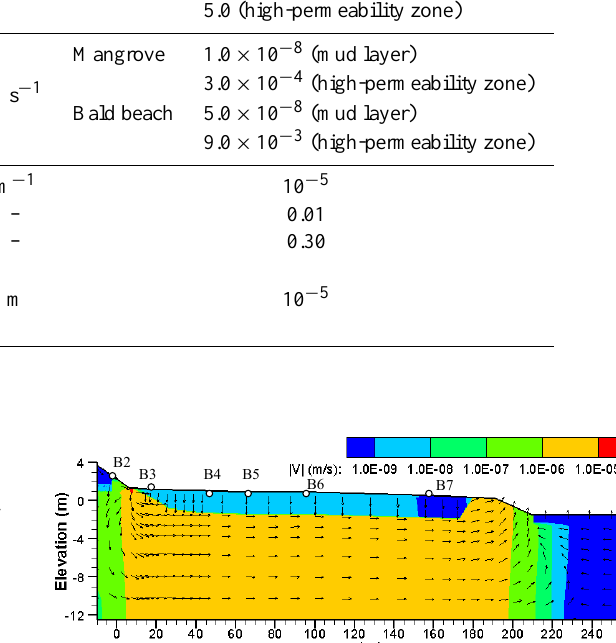
Fig. 10. Average Darcy velocity (banded colorful contours) in the bald beach transect calculated over the observation period of 3 days. Vectors with uniform length were used to indicate the velocity direction only.